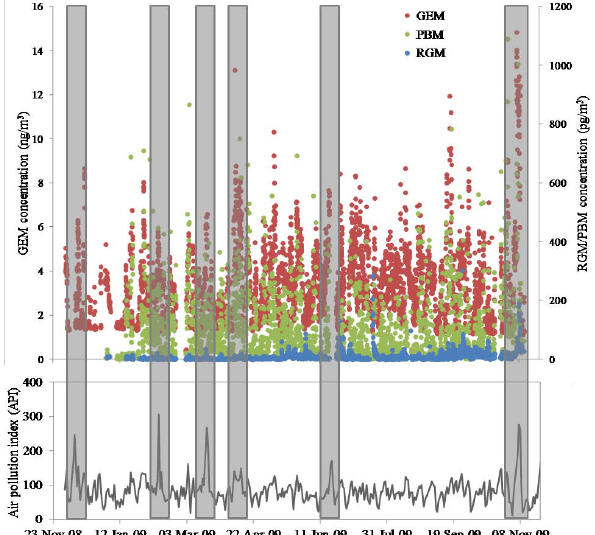
Fig. 2. Hourly averaged GEM, RGM and PBM concentrations at the monitoring site and air pollution index (API) in the Beijing urban area from December 2008 to November 2009. Notes: the six grey columns are typical heavy pollution episodes in Beijing urban area.